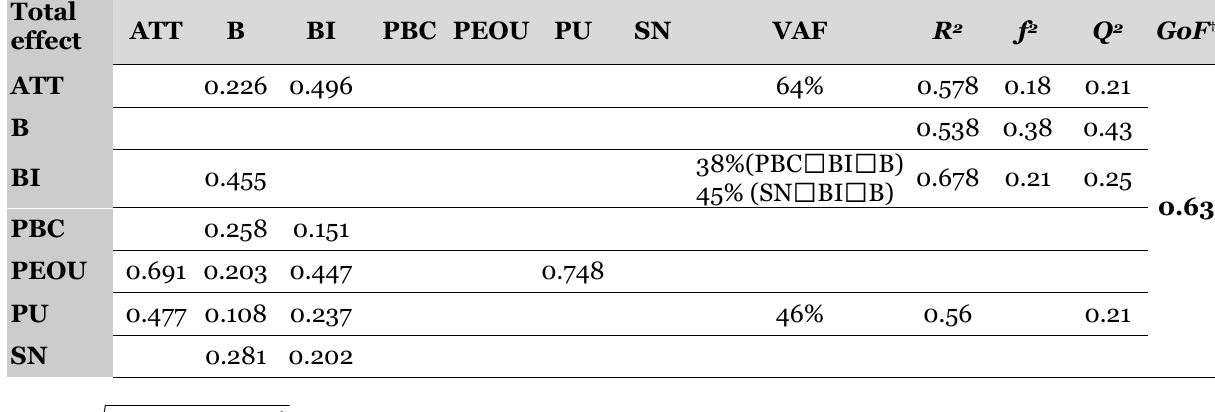
Regression Analysis of Mediation Effect Total